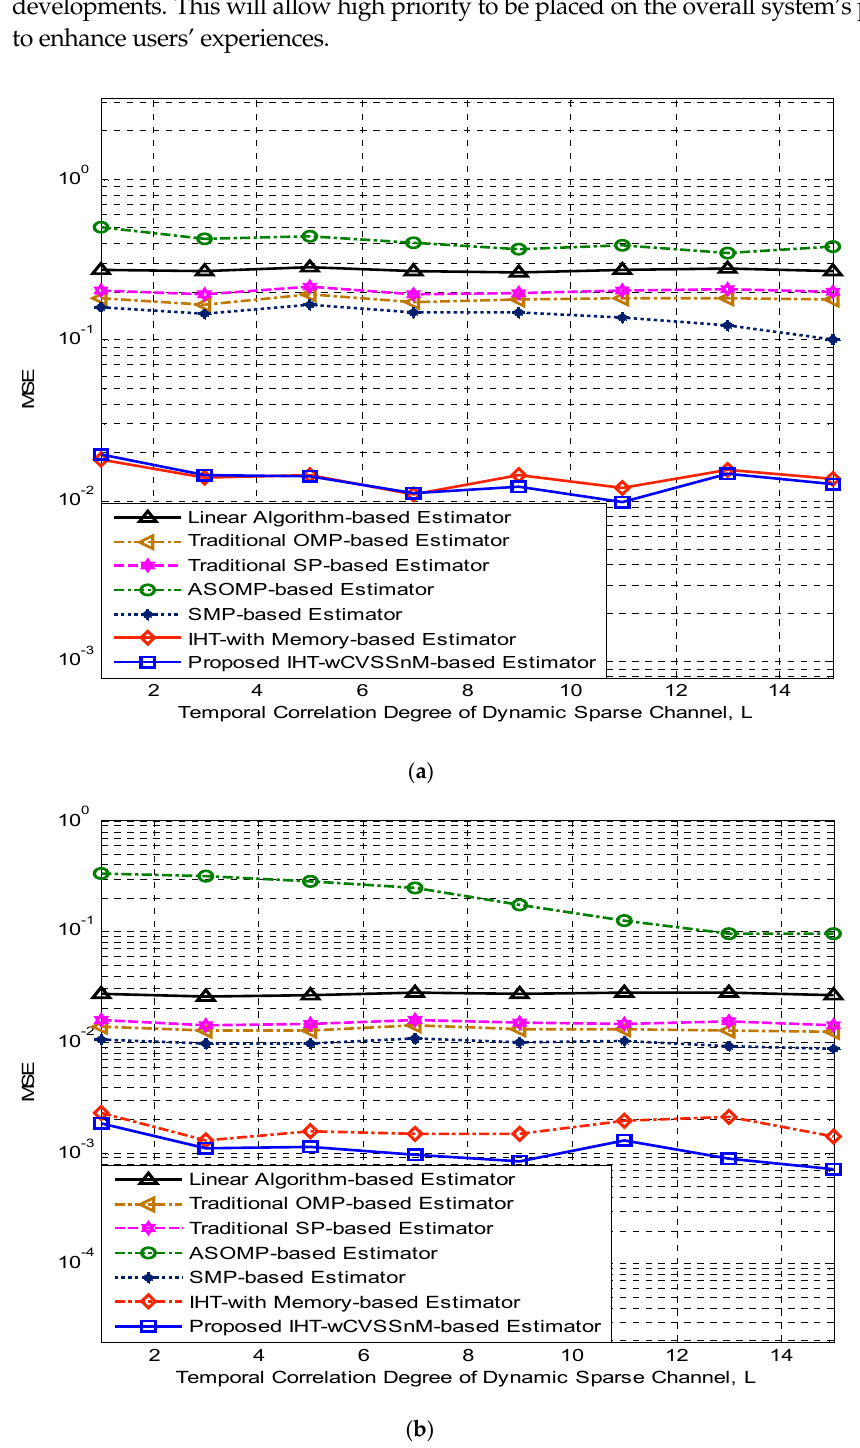
Linear Algorithm-based Estimator Traditional OMP-based Estimator Traditional SP-based Estimator ASOMP-based Estimator